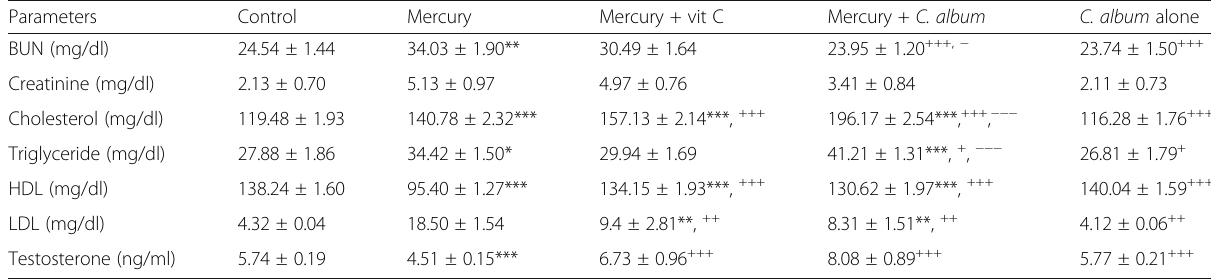
Table 2 Protective effect of C. album extract against HgCl 2 -induced alteration in plasma BUN, creatinine, cholesterol, triglyceride, HDL, and LDL